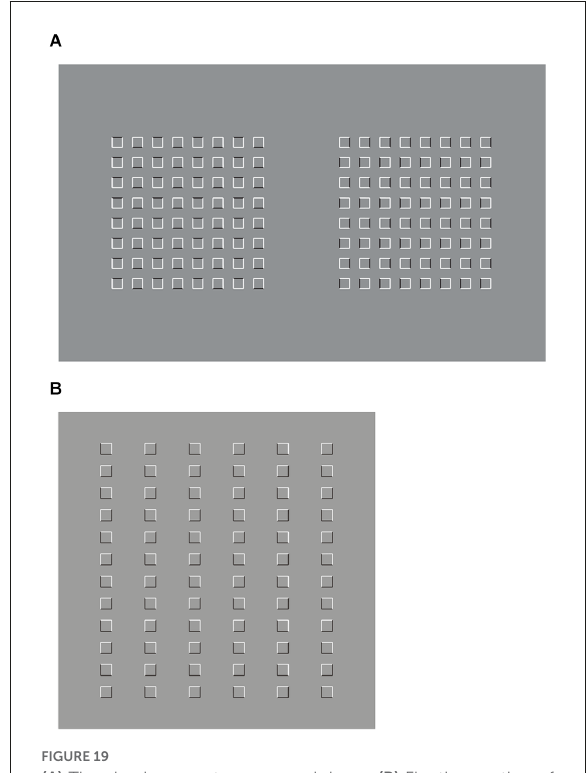
FIGURE19 (A) The checks seem to go up and down. (B) Floating motion of the checks perceived as rhombic shapes or as stretched squares on opposite